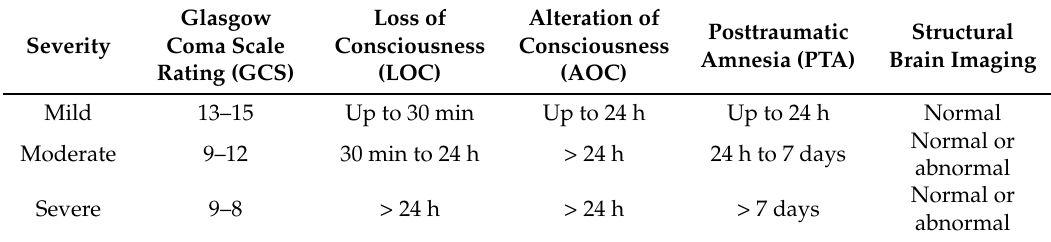
Table 1. Severity of traumatic brain injury